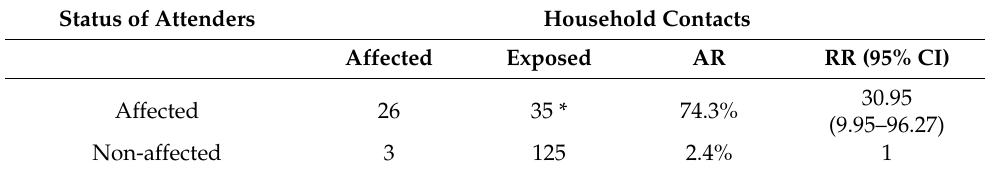
Table 3. Attack rates in household contacts according to the clinical status of daycare attenders. Status of Attenders